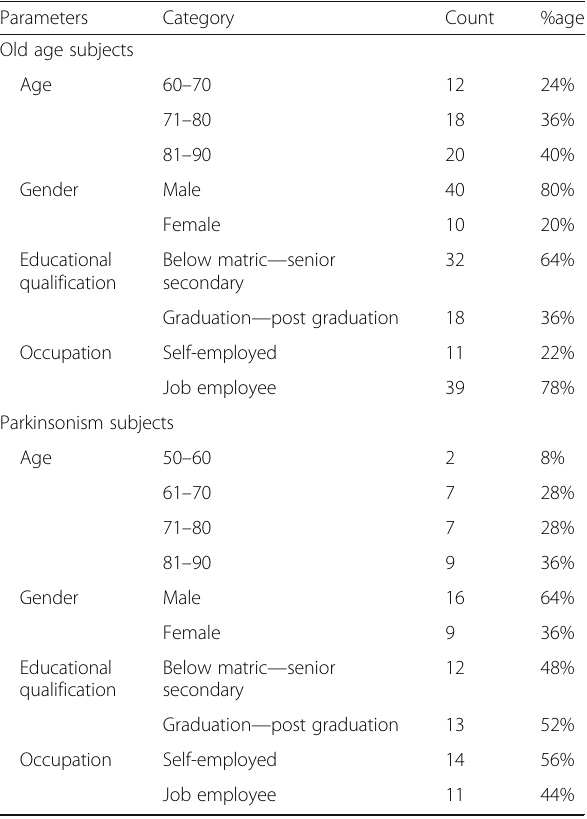
Table 1 Background details of old age and